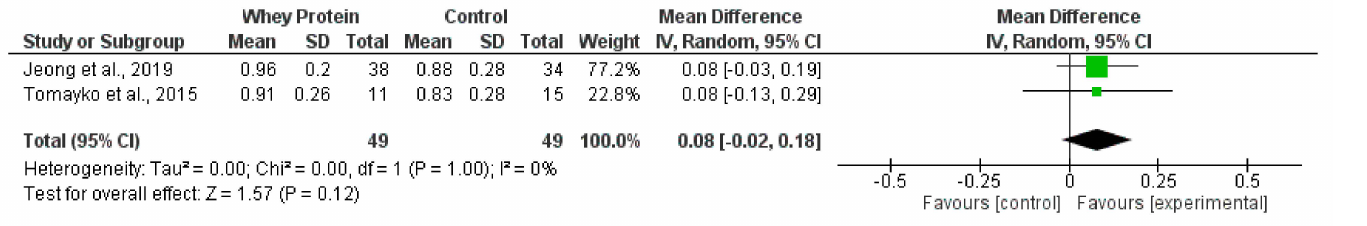
Figure 10. Effect of whey protein supplementation on gait speed (m/s) in individuals receiving haemodialysis. Data are expressed as mean difference and 95% CI. Data for whey protein and control groups from both trials [22,66].